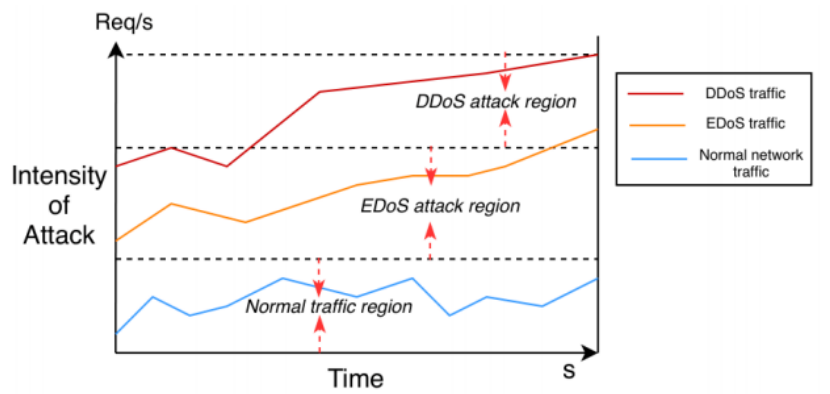
Figure 1. DDoS and EDoS attacks regions.